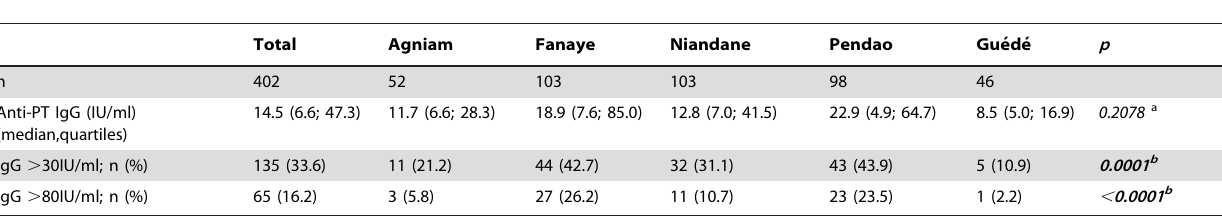
Table 2. PT-IgG responses at